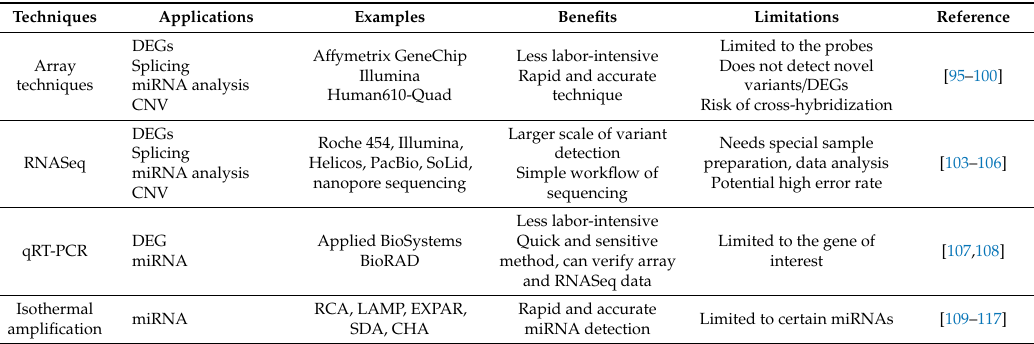
Table 3. Techniques used in transcriptomic